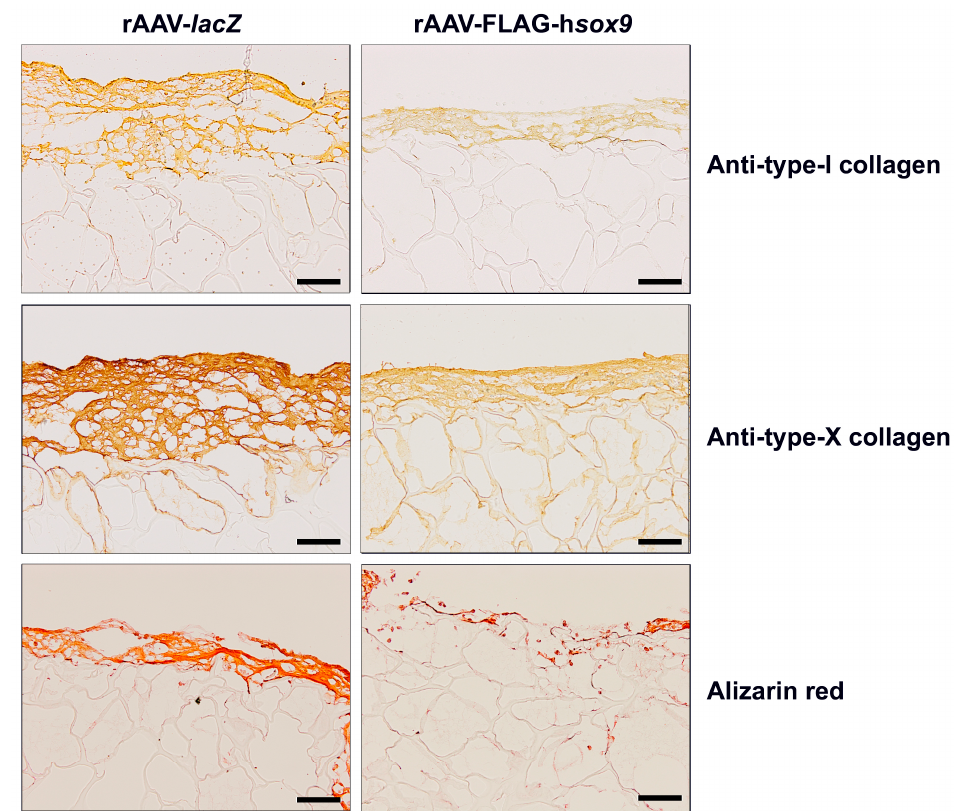
Figure 5. Immunohistochemical analysis in hydrodynamic cultures of rAAV-transduced hMSCs seeded in fibrin-PU scaffolds. Cells were transduced, seeded in PU scaffolds, and placed in rotating bioreactors as described in the Figures 1–4 and in Materials and Methods. The samples were processed after 21 days to detect immunoreactivity to type-I and -X collagen and for histological staining with alizarin red (magnification × 10; scale bar: 200 µ m; all representative data). Note the high signals at the surface of the constructs as a result of a diffusion gradient of the